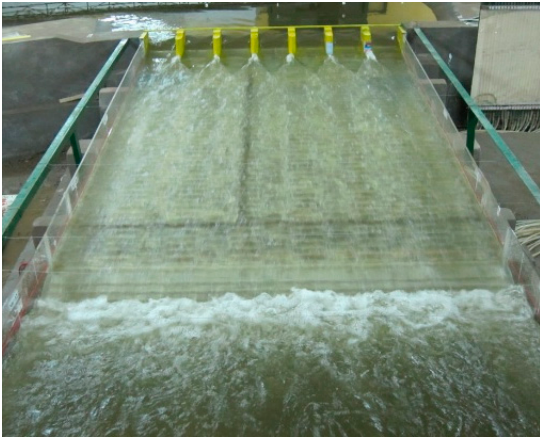
Figure 15. Steady hydraulic jump when Z up = 52 m in the complete case [16].